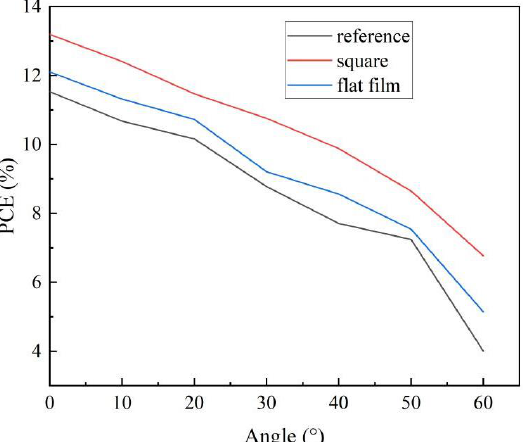
Figure 9. Dependence of the solar cell PCEs on an incident angle with and without the photoresist film MLAs.